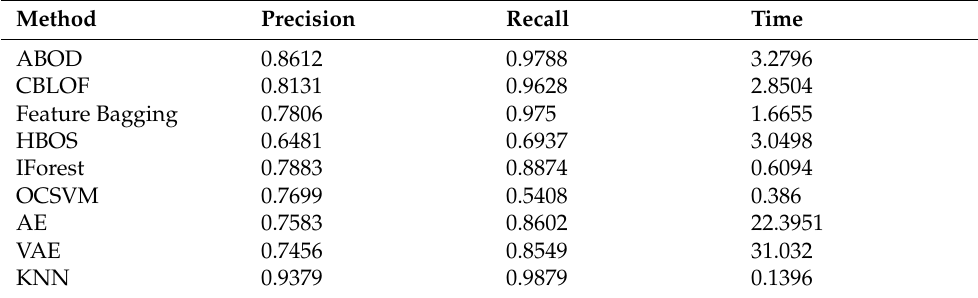
Table 3. Comparison of each anomaly detection algorithm based on precision and time